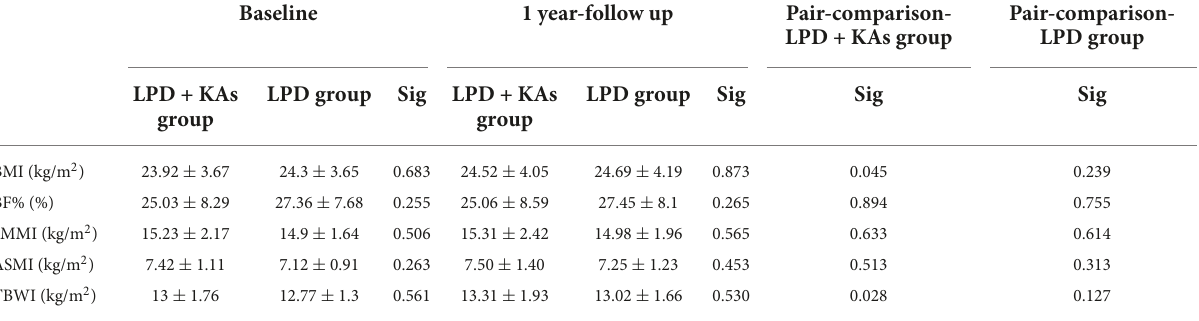
TABLE 3 Body composition analysis of study participants at baseline and at the end follow up. Baseline 1 year-follow up Pair-comparison- LPD + KAs